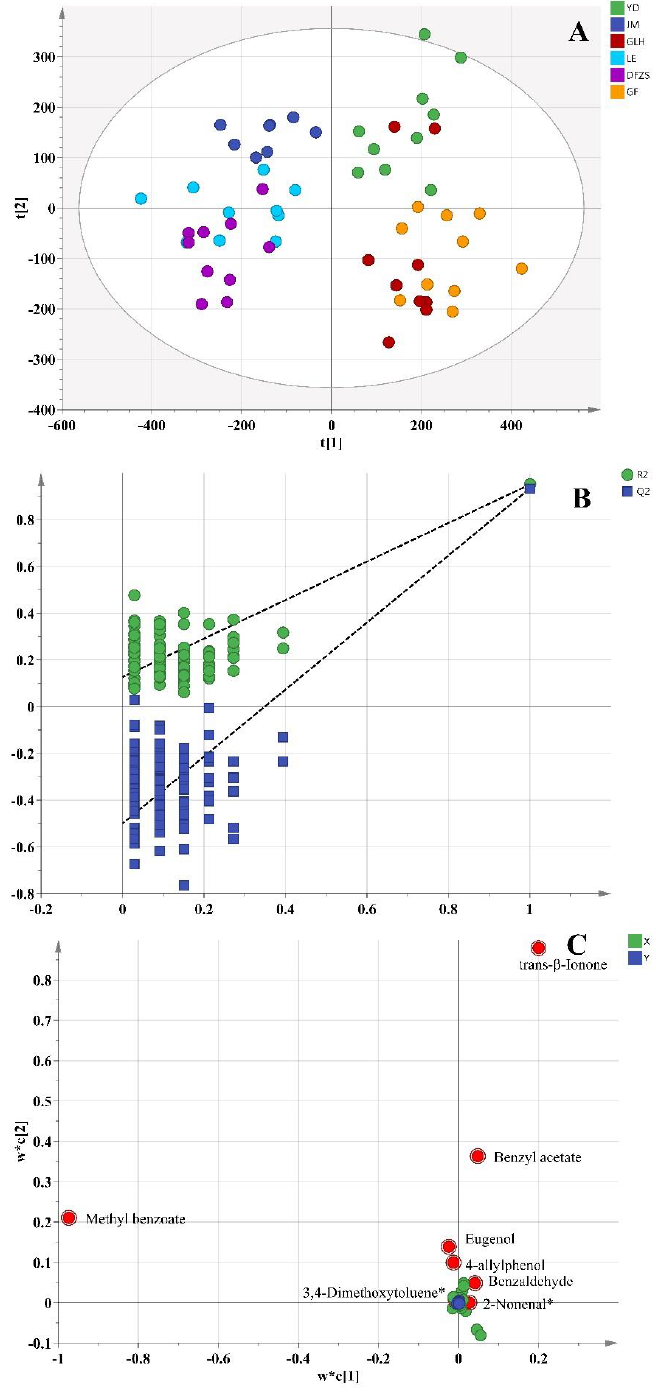
Figure 4. PLS-DA analysis of volatile compounds based on their OAVs in six varieties of P. mume blossom samples. ( A ) PLS-DA score plot; ( B ) cross-validation plot of the PLS-DA model with 100 permutation tests; ( C ) loading plot of PLS-DA (red dot represents the most differential compounds, VIP > 1). “*” indicates that the compound may be other isomers.